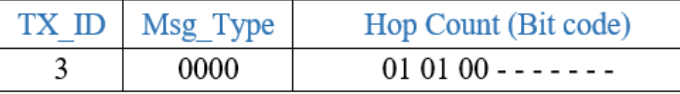
Figure 7. Neighbor discovery packet of node N 3 .